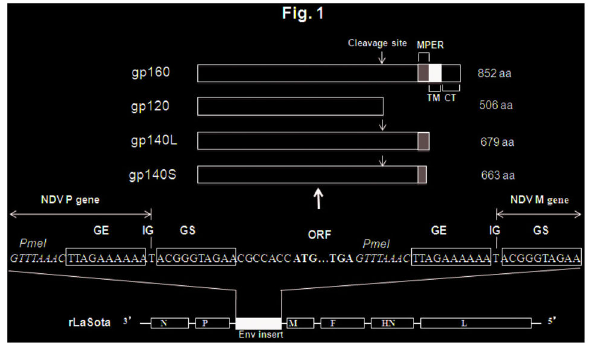
Figure 1. Gene map of recombinant NDV LaSota (rLaSota) and structures of gp160, gp120, gp140L, and gp140S. The proteins are shown as unprocessed primary translation products annotated to show the locations of the furin cleavage site, the membrane-proximal external region (MPER), the transmembrane (TM) and cytoplasmic (CT) domains, and the total aa lengths. The cDNAs encoding these proteins were modified by PCR to add NDV gene-start (GS) and gene-end (GE) transcription signals, an intergenic (IG) nucleotide, and flanking PmeI sites, and were inserted individually between the NDV P and M genes. Sequence flanking the Env ORFs is shown in positive-sense, and PmeI sites used in the construction are shown in italics. NDV genes (N, nucleoprotein; P, phosphoprotein; M, matrix protein; F, fusion glycoprotein; HN, hemagglutinin-neuraminidase protein; L, large polymerase protein) are shown as open boxes. doi: